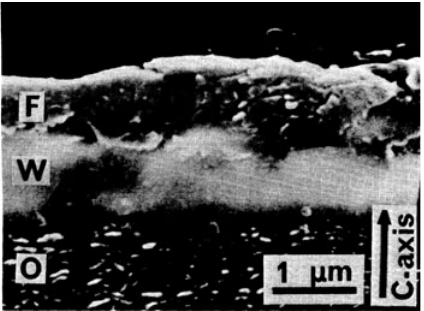
Figure 5 Strength of original fi ber ( (cid:1) ), HNO removed fi bers ( (cid:2) , × ) after heat treatment. Numbers denote V